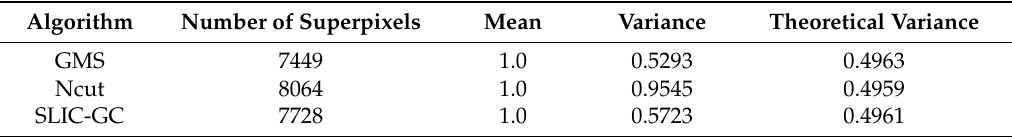
Table 4. Execution times of the different superpixel segmentation algorithms with the ESAR image.